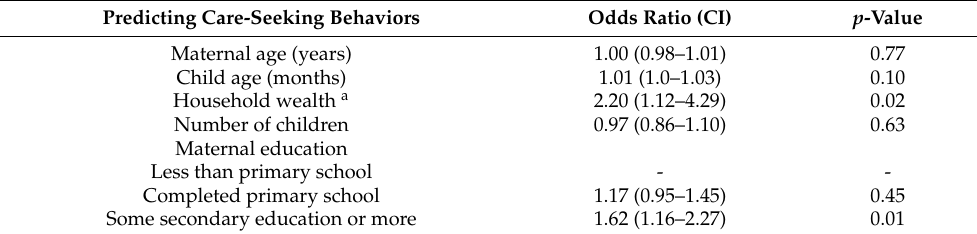
Table 5. Regression analysis for variables associated with care-seeking behaviors for diarrhea (N =